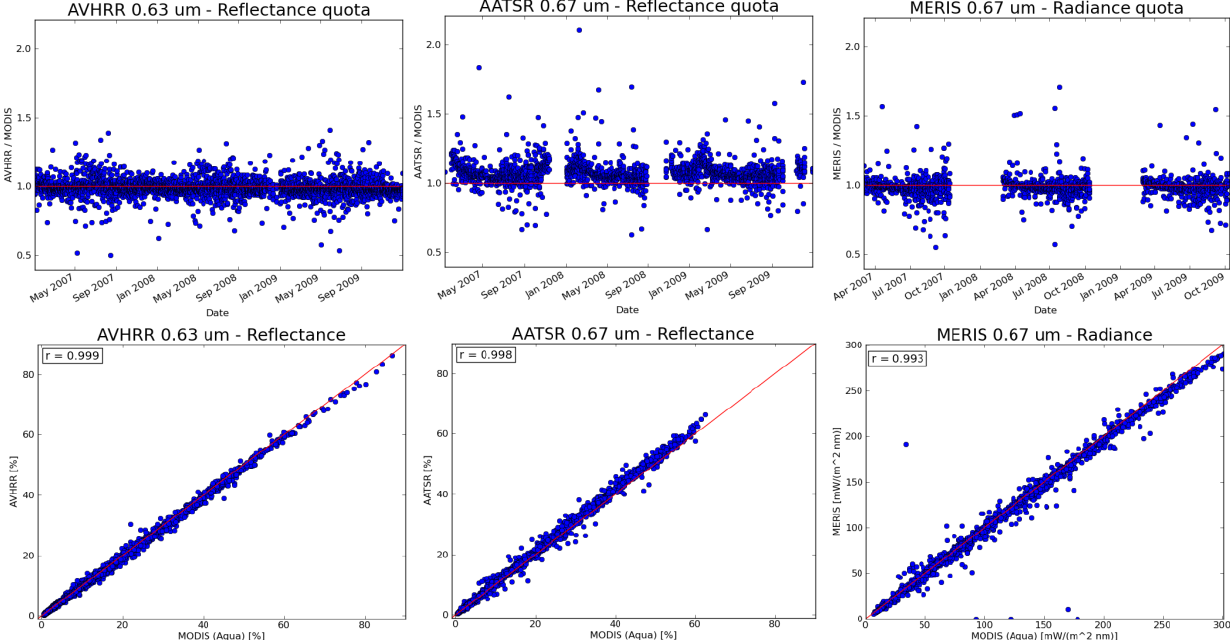
Figure 4. Inter-comparison of radiances against MODIS for the AVHRR-heritage channel at 0.6 µm for AVHRR ( Left ), AATSR ( Middle ), and MERIS ( Right ). Upper panels show results expressed as reflectance factor quotas or radiance quotas over the full time series and lower panels show results expressed as scatter plots. Time period is from January 2007 to December